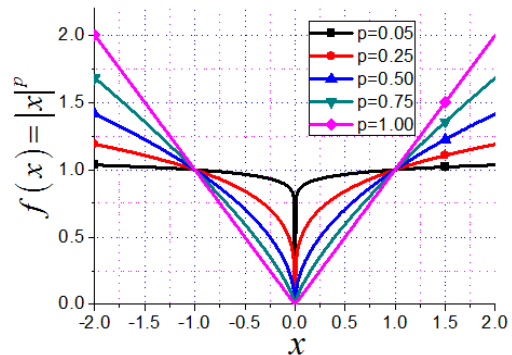
Figure 7. The value of f ( x ) = | x | p versus the value of p